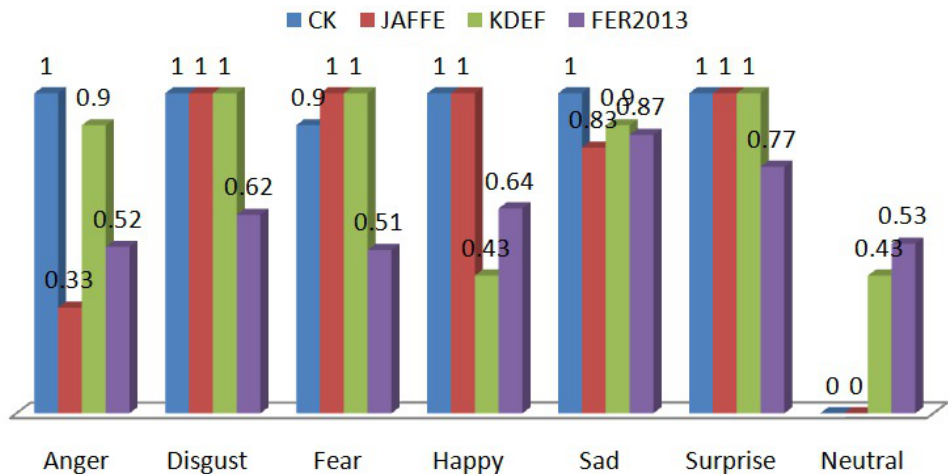
Figure 11. Recall for CK+, JAFFE, KDEF and FER2013 datasets.